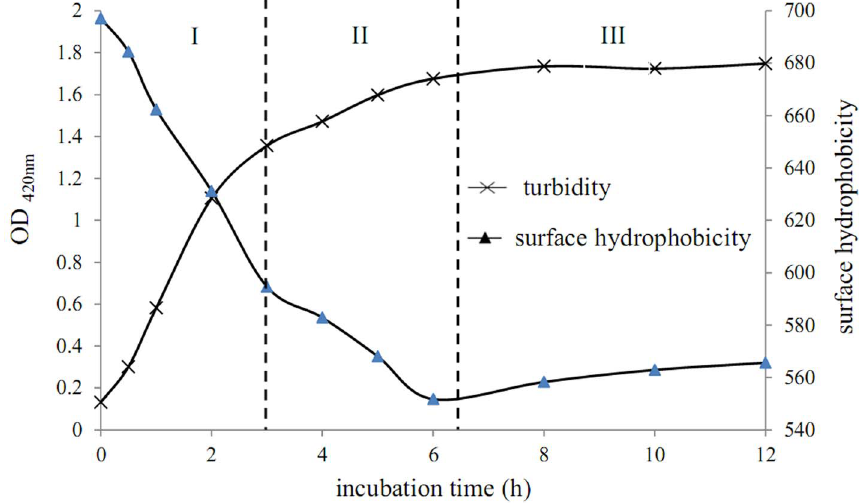
Figure 8. Turbidity and surface hydrophobicity of aggregates obtained at different incubation times.